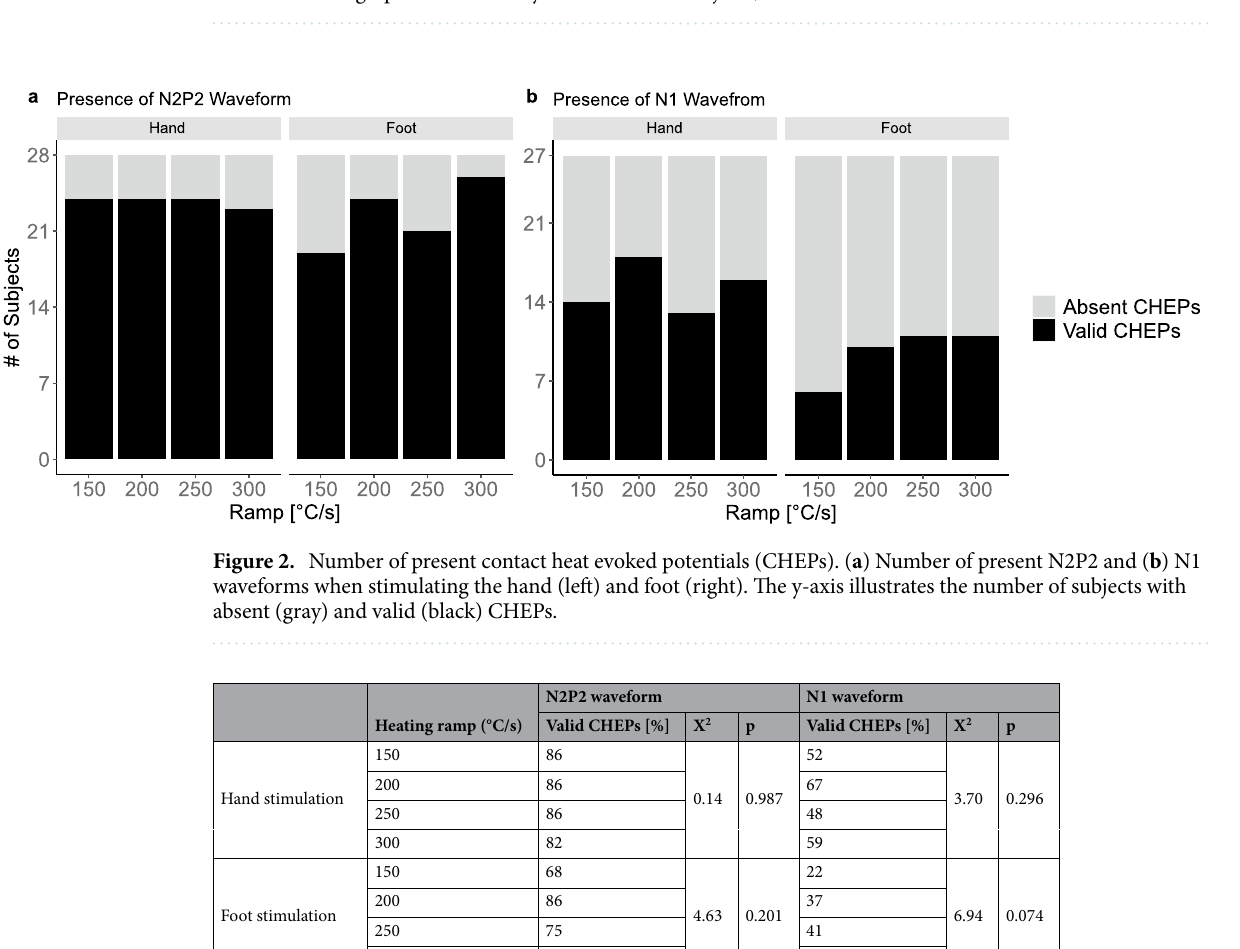
Table 1. Demographics of the study cohort. N: # of subjects, sd: standard deviation.